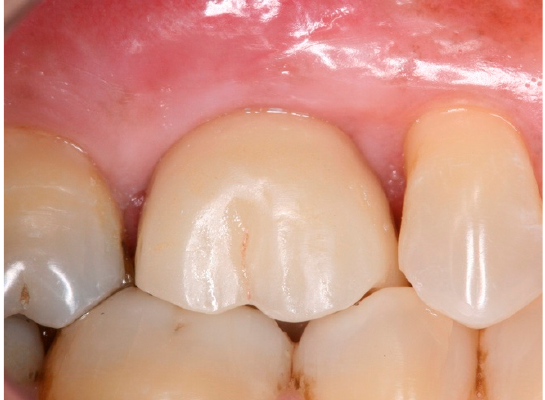
Figure 17. Intra-oral buccal view of #16 with ceramic screwed retained crown in function for 25 months.